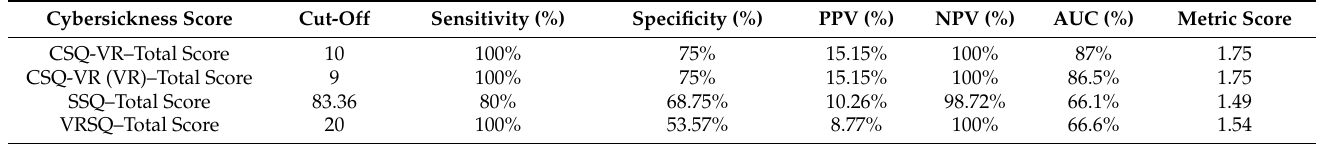
Table 5. Psychometric Properties of the CSQ-VR, SSQ, and VRSQ in detecting Reaction Speed Decline. Cybersickness Score Cut-Off